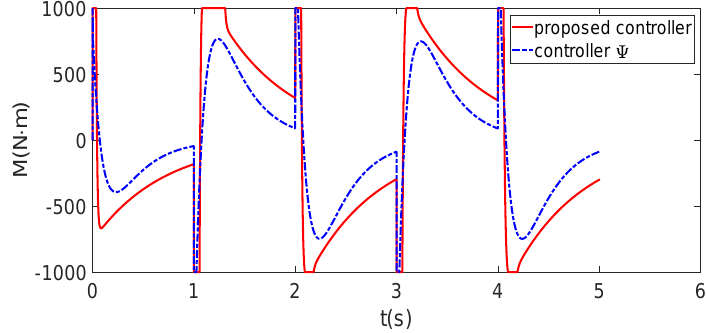
Figure 10. Yaw motion control input.